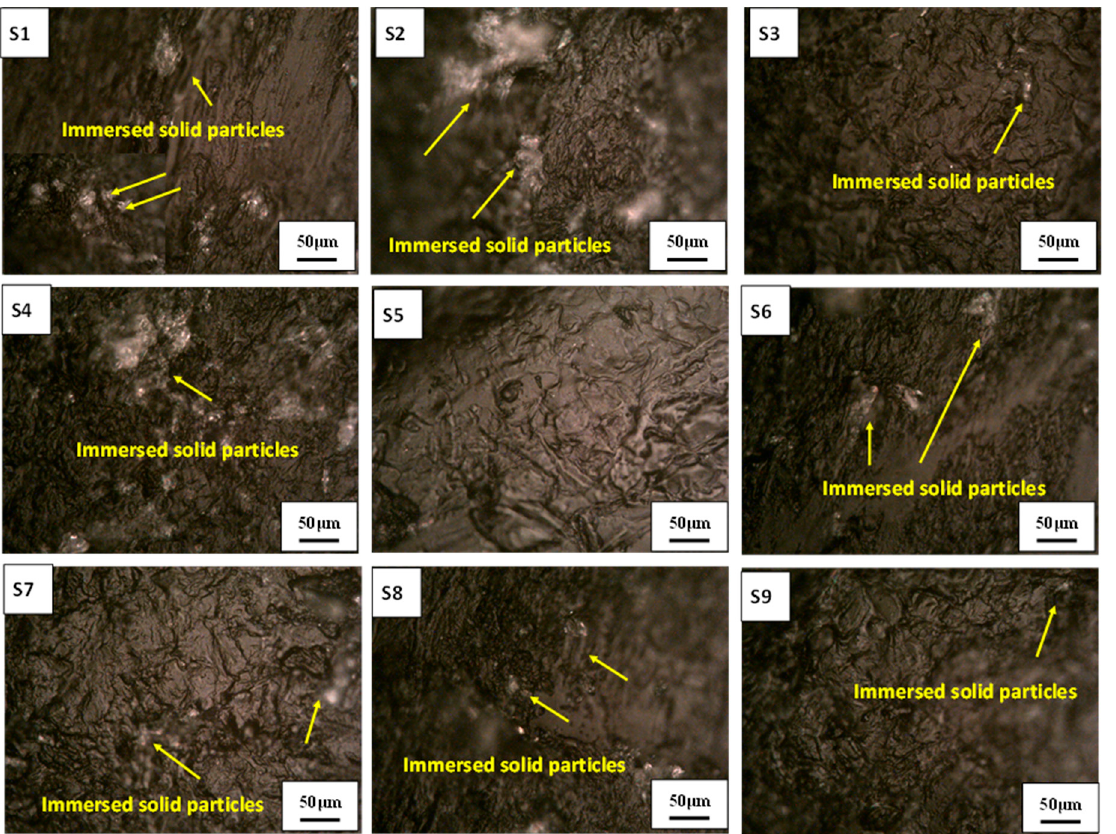
Figure 9. Optical microscopy of the FDMed PLA specimens after subjecting them to the slurry impacts. S1 (BO: Y, LT: 0.1, IA: 15°), S2 (BO: Y, LT: 0.2, IA: 45°), S3 (BO: Y, LT: 0.3, IA: 90°), S4 (BO: 45°, LT: 0.1, IA: 45°), S5 (BO: 45°, LT: 0.2, IA: 90°), S6 (BO: 45°, LT: 0.3, IA: 15°), S7 (BO: X, LT: 0.1, IA: 90°), S8 (BO: X, LT: 0.2, IA: 15°), and S9 (BO: X, LT: 0.3, IA: 45°).